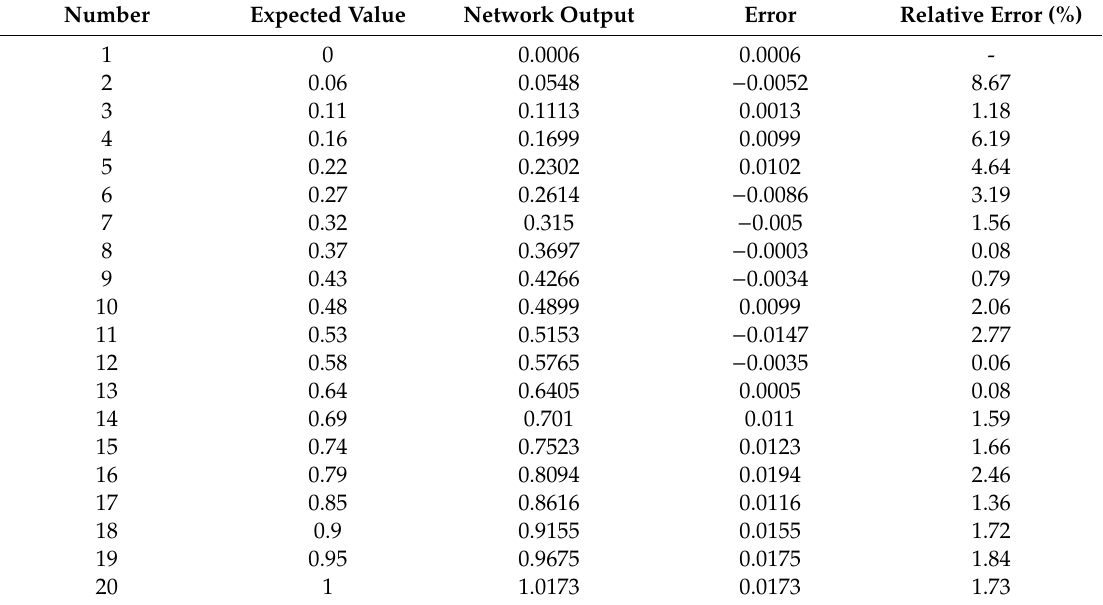
Figure 7. Training results of the LM-BP neural network ( a ) and Convergent curve ( b ). Table 5. Test error of the model.